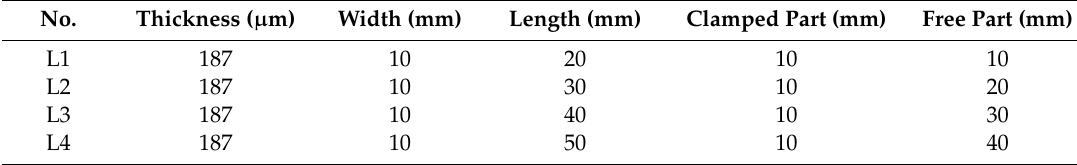
Table 1. Dimensions of the built IPMC